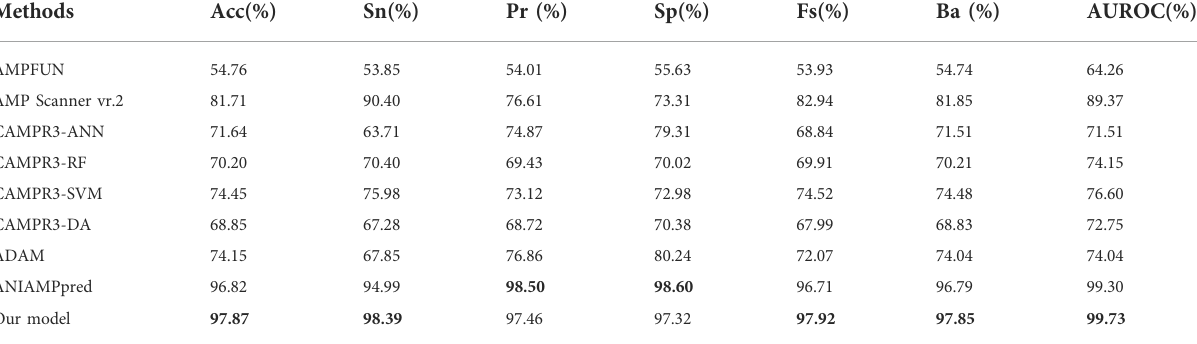
TABLE 3 Performance comparison of different